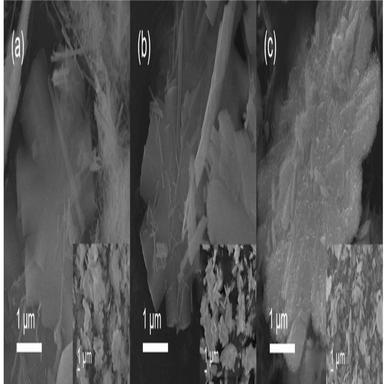
SEM images of the heterostructures between Co(OH)F microflowers and Zn(OH)F nanorods with different mixing processes: (a) in a vial, (b) in a microwave at 120 ◦C for 20 min, and (c) in a microwave at 200 ◦C for 20 min.